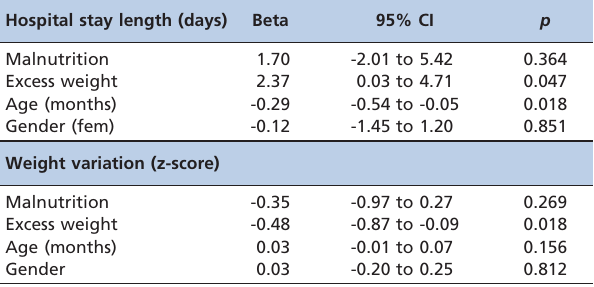
Table 2 - Multivariate linear regression analysis of the adjusted effect of nutritional status on the length of stay and in-hospital weight